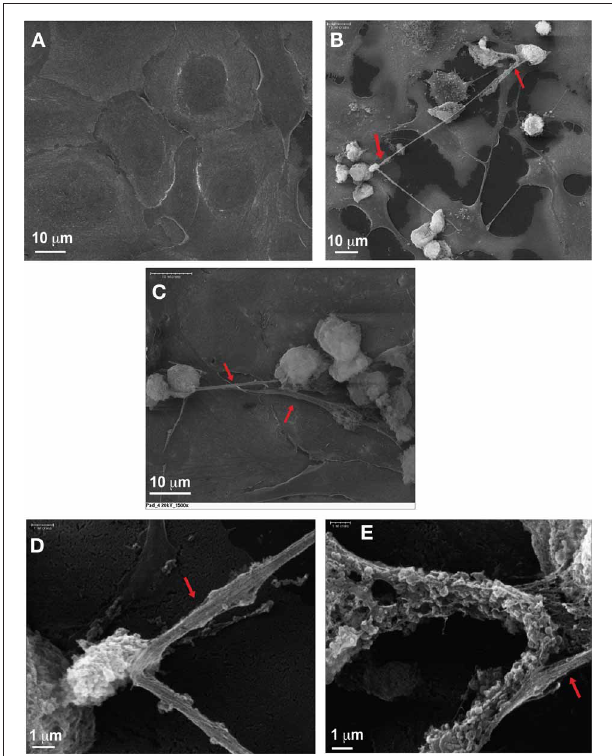
FIGURE 2 | Scanning electron microscope analyses of extracellular chromatin fibers. (A) U2OS cells without forced HA-PAD4 expression. (B–E) U2OS cells with forced HA-PAD4 expression, showing the decondensed chromatin fibers (denoted by red arrows). Also noticeable is the membrane vesicles attached to the chromatin fibers in (E)